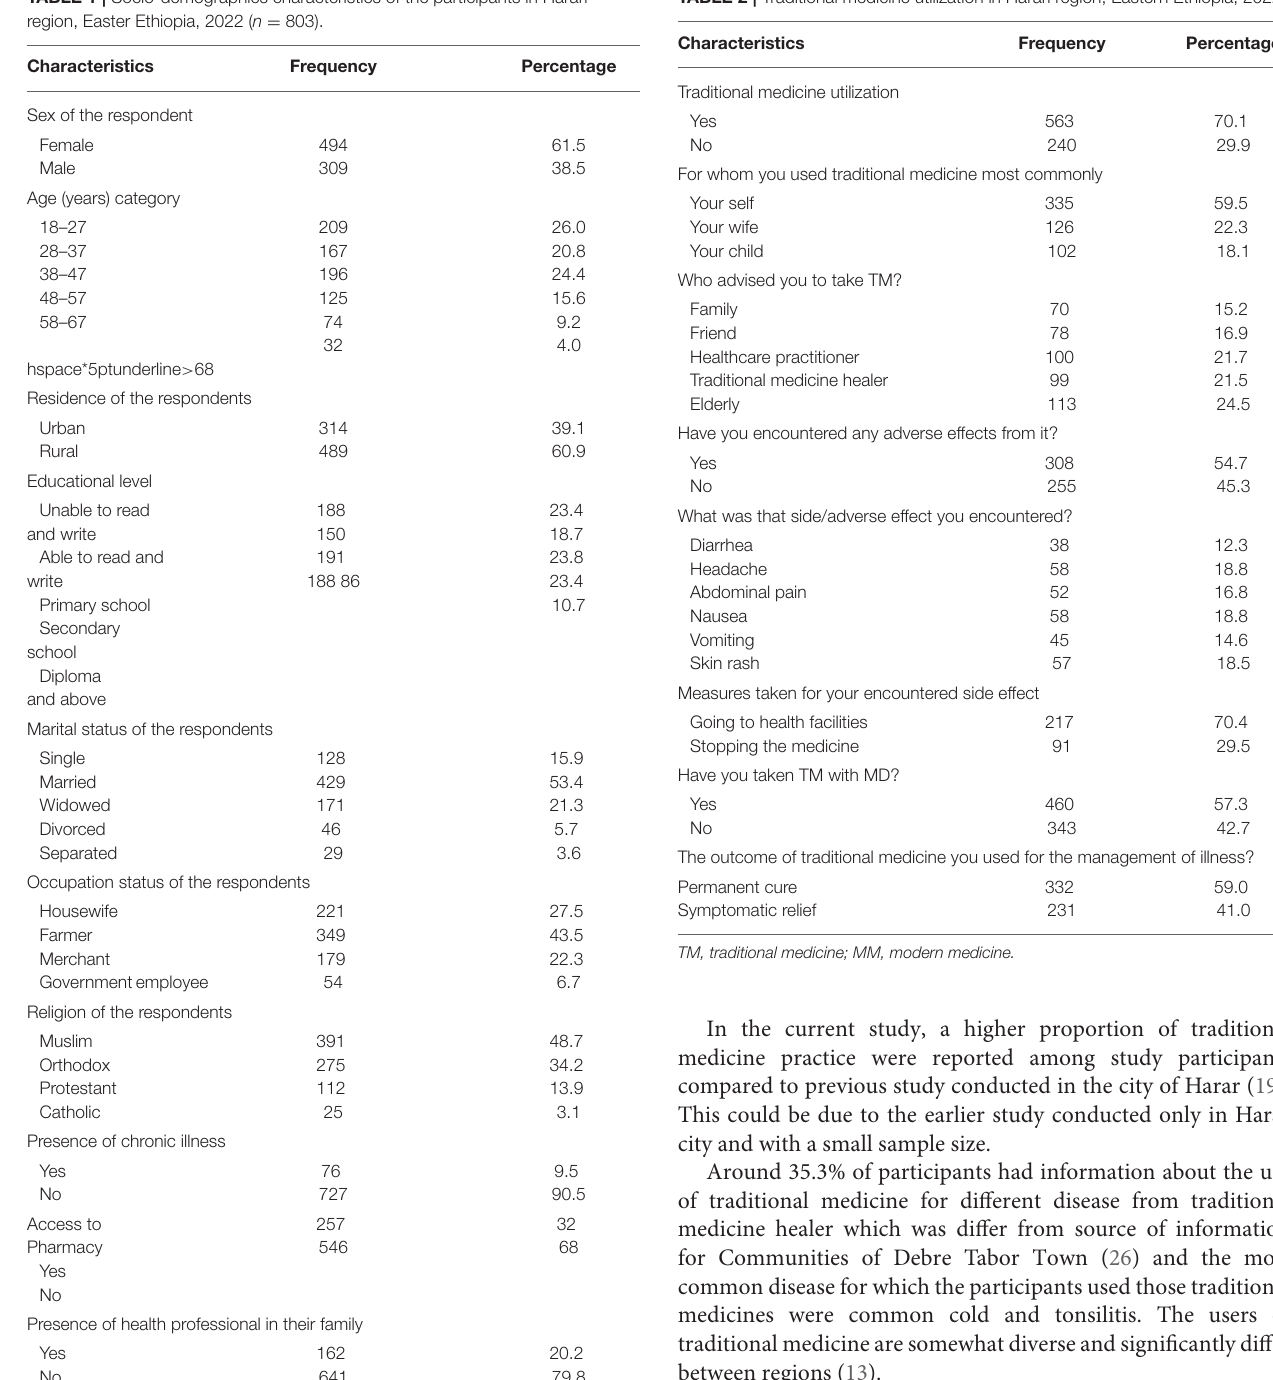
TABLE 2 | Traditional medicine utilization in Harari region, Eastern Ethiopia,